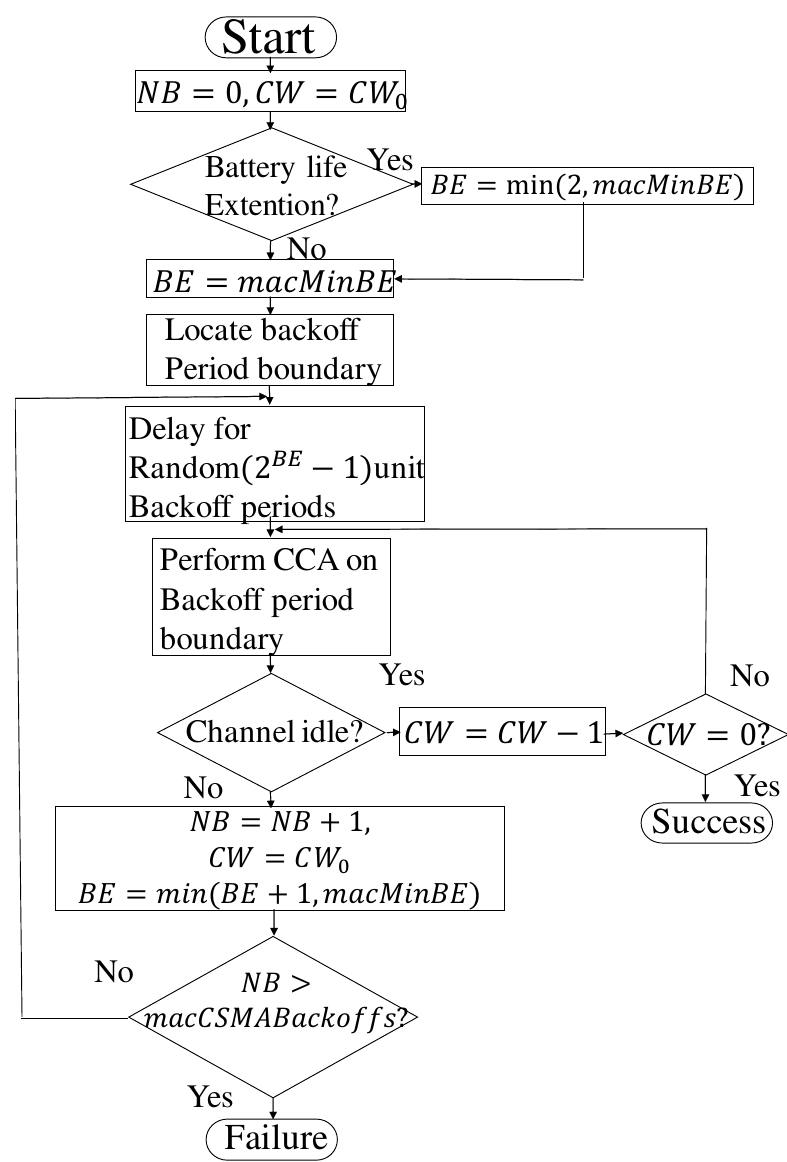
Figure 2. Flow chart of IEEE 802.15.4 packet